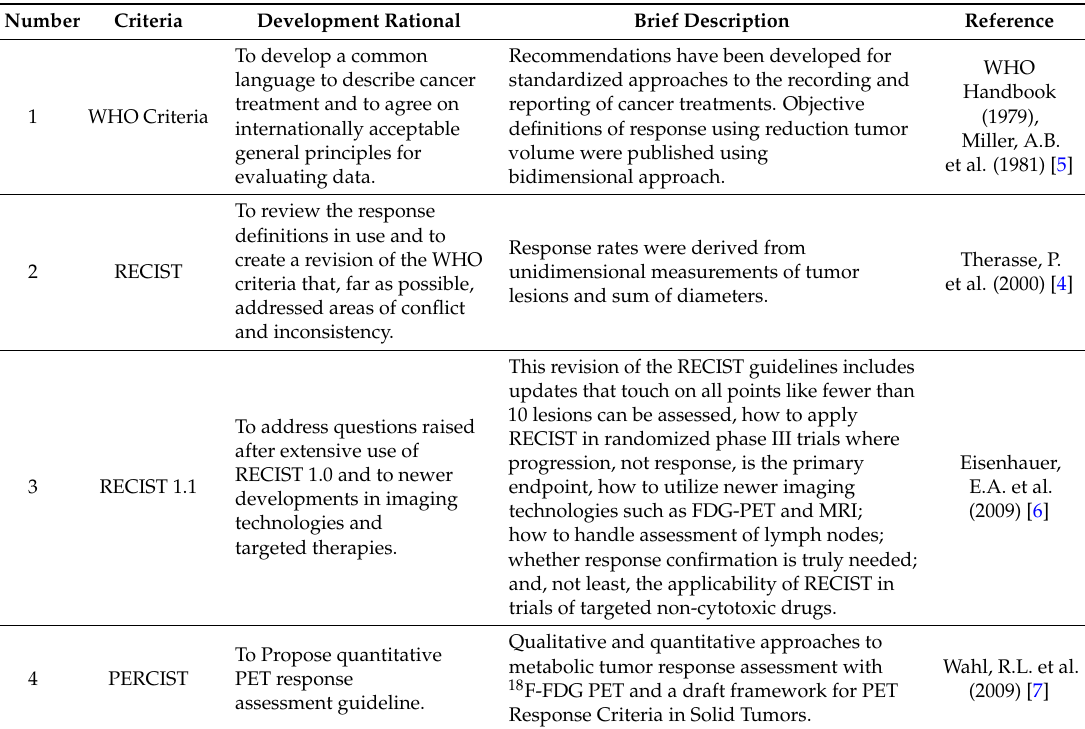
Table 1. Major response assessment